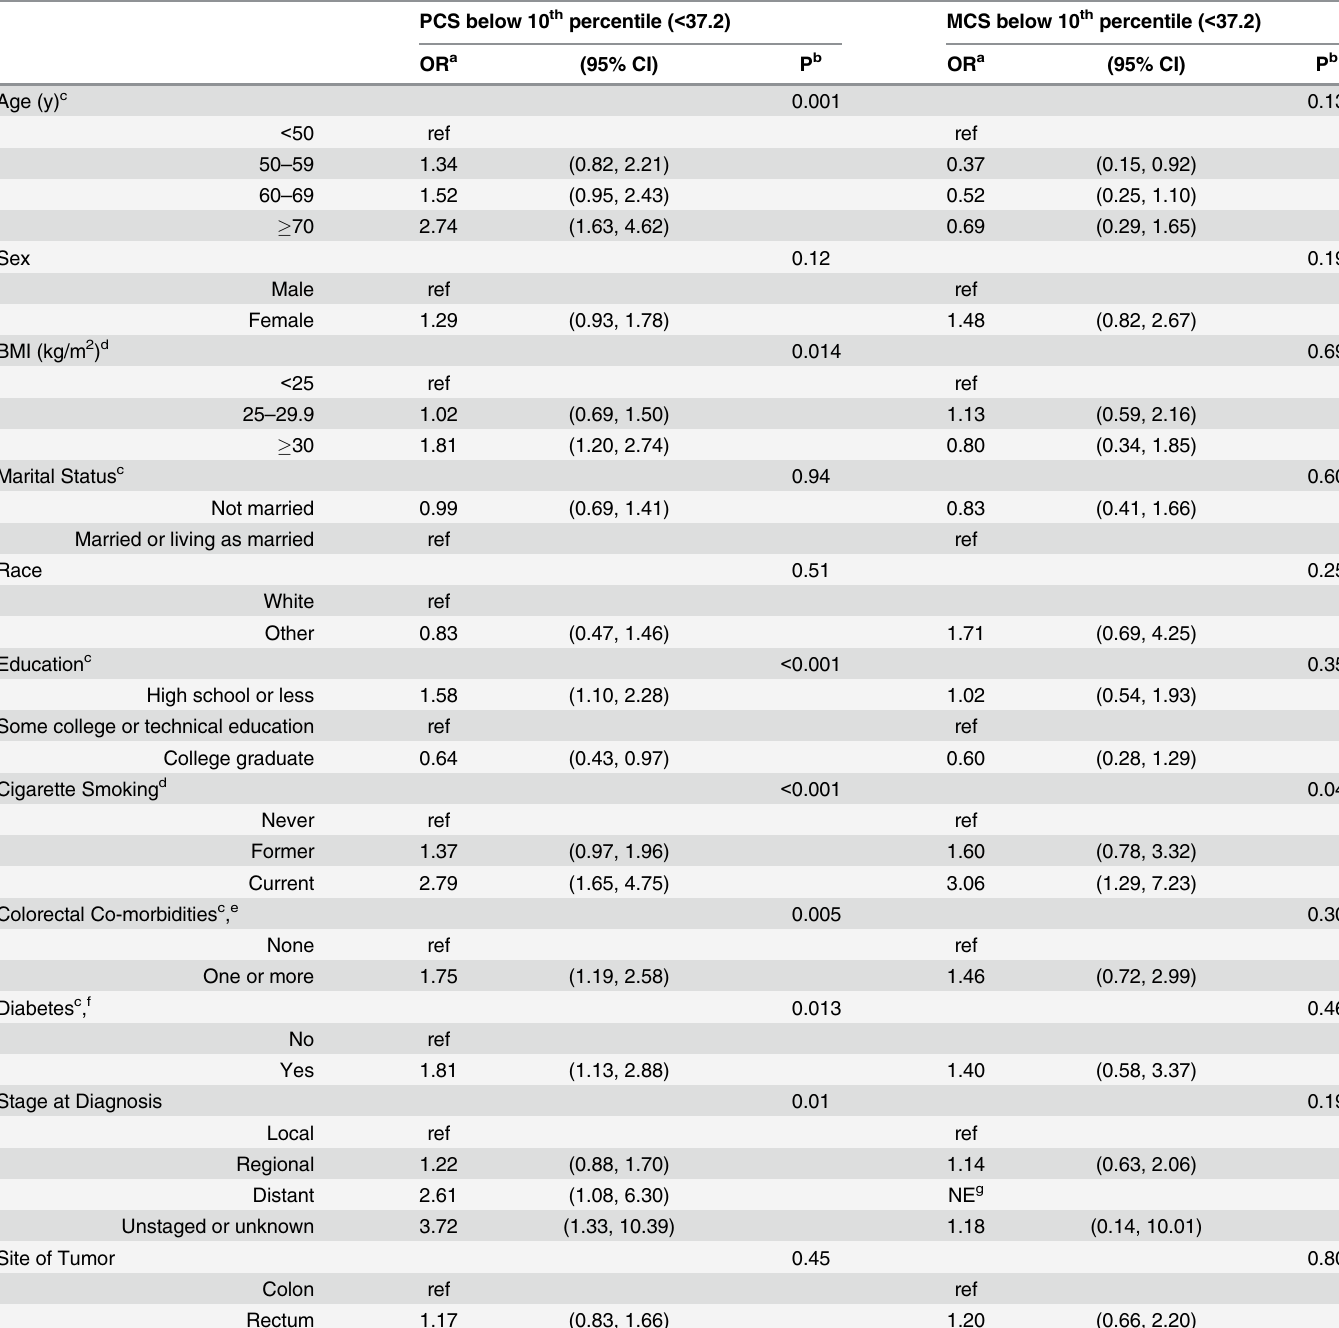
Table 2. Associations of survivor personal characteristics with VR-12 Physical Component Summary (PCS) or Mental Component Summary (MCS) score below 10 th percentile value in the general population, among CRC survivors approximately 5 years after diagnosis, Seattle Colon Can- cer Family Registry (enrolled 1998 –